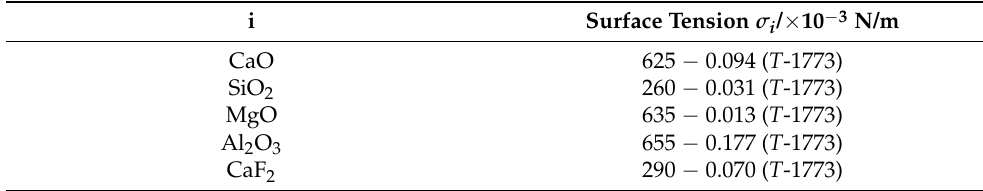
Table 5. Surface tension of each component in slag